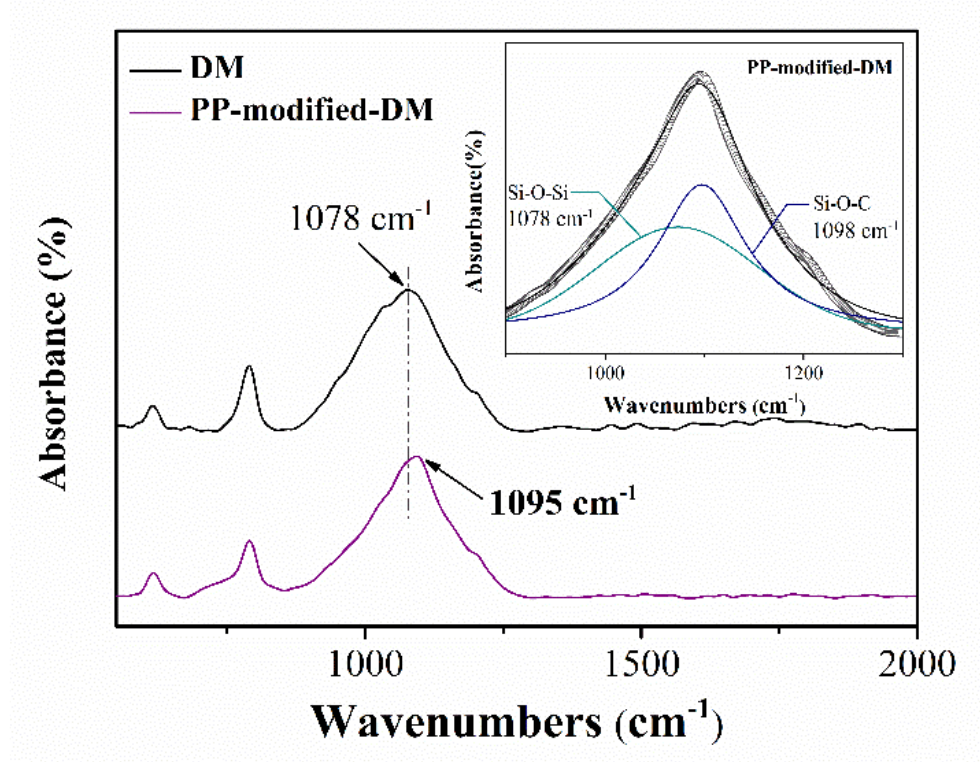
Figure 5. FTIR spectra of PP–modified–DM and DM samples after heat treatment.